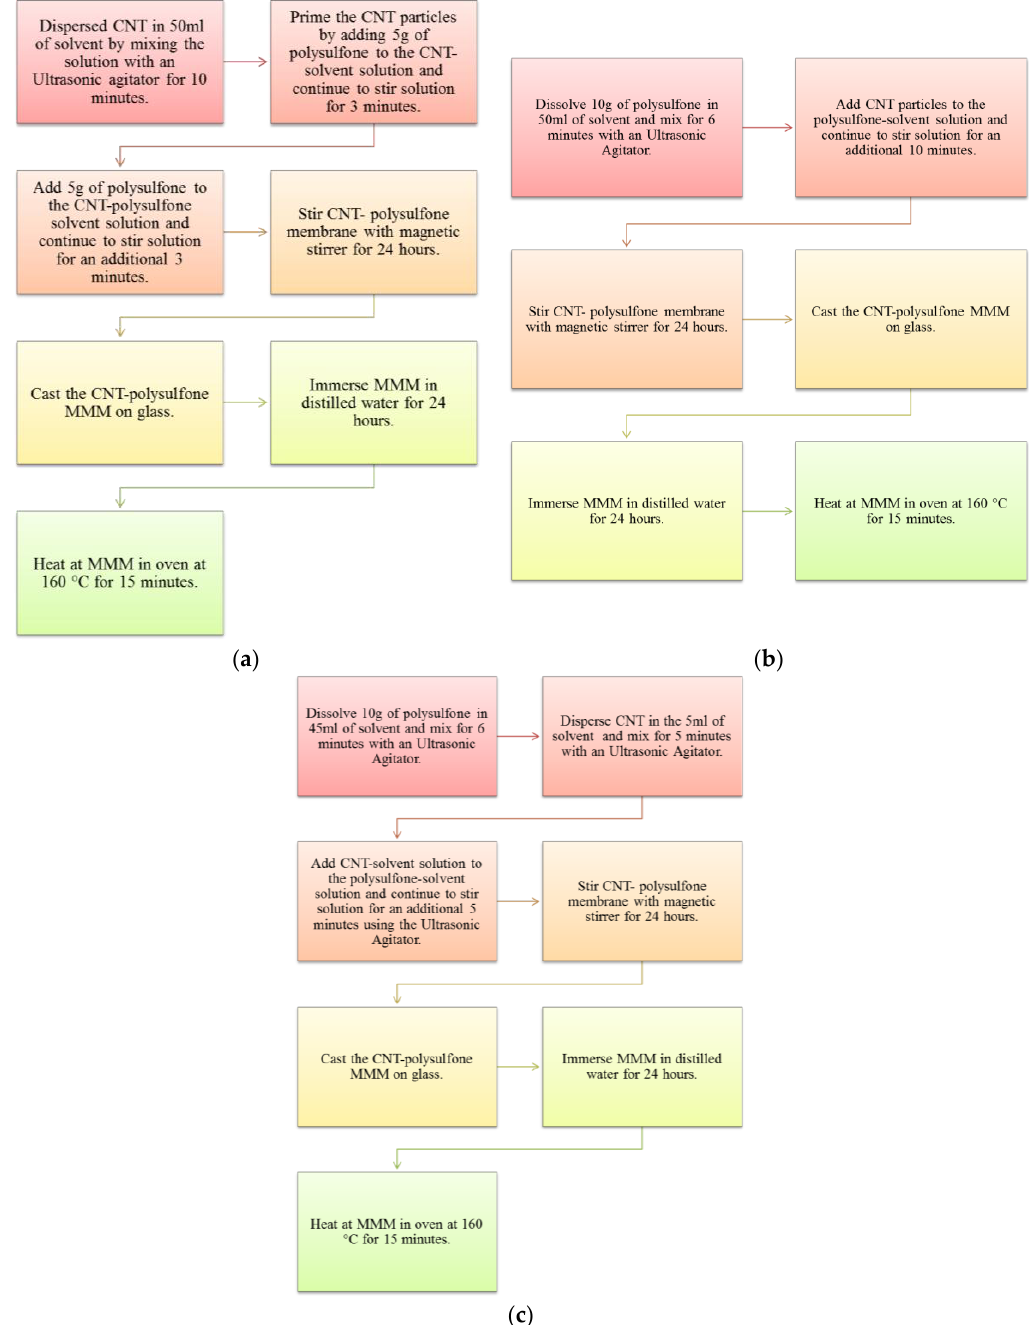
Figure 1. Dispersion methods employed during the synthesis of the carbon nanotube/polysulfone (CNT/Psf) composite membranes. Method 1 (M1) ( a ); Method 2 (M2) ( b ); and Method 3 (M3) ( c ) (Adapted from reference [1].